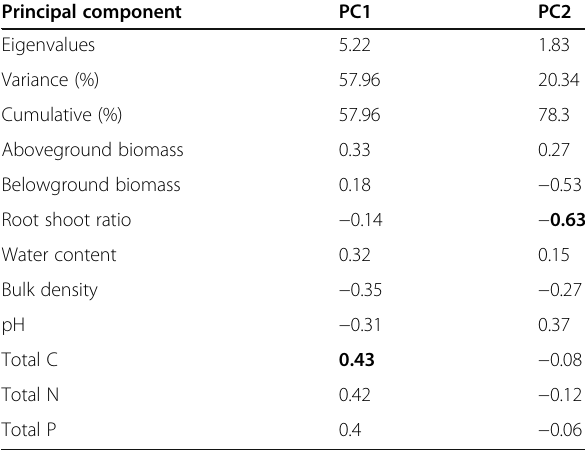
Table 2 Principal component analysis of soil quality indicators Principal